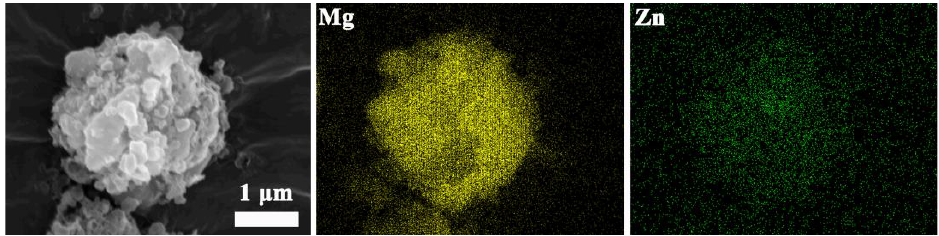
Figure 9. The element mapping images of MgH 2 -5 wt% ZnO composite after dehydrogenation. The elements of Mg and Zn also uniformly distributed, and it is proven that the Mg x Zn y turns into MgZn 2 . It can be seen that after the addition of ZnO, the catalyst does not decompose. The phase of the catalyst will be transformed when the sample changes to the hydrogen absorption or hydrogen desorption state.